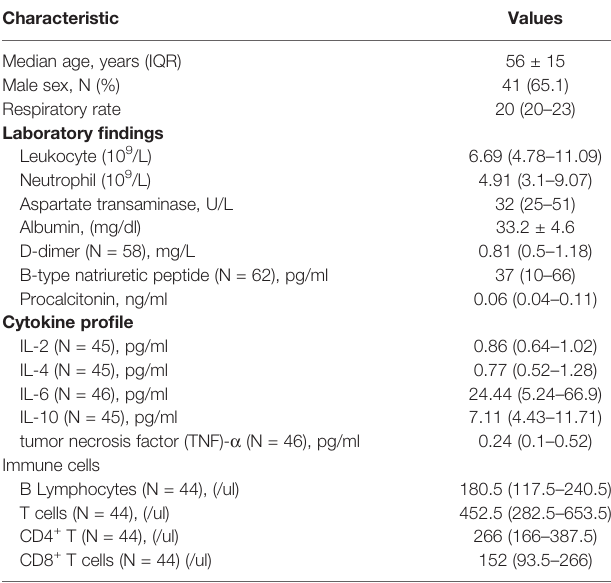
TABLE 1 | Baseline characteristics of studied variables in the patients (on